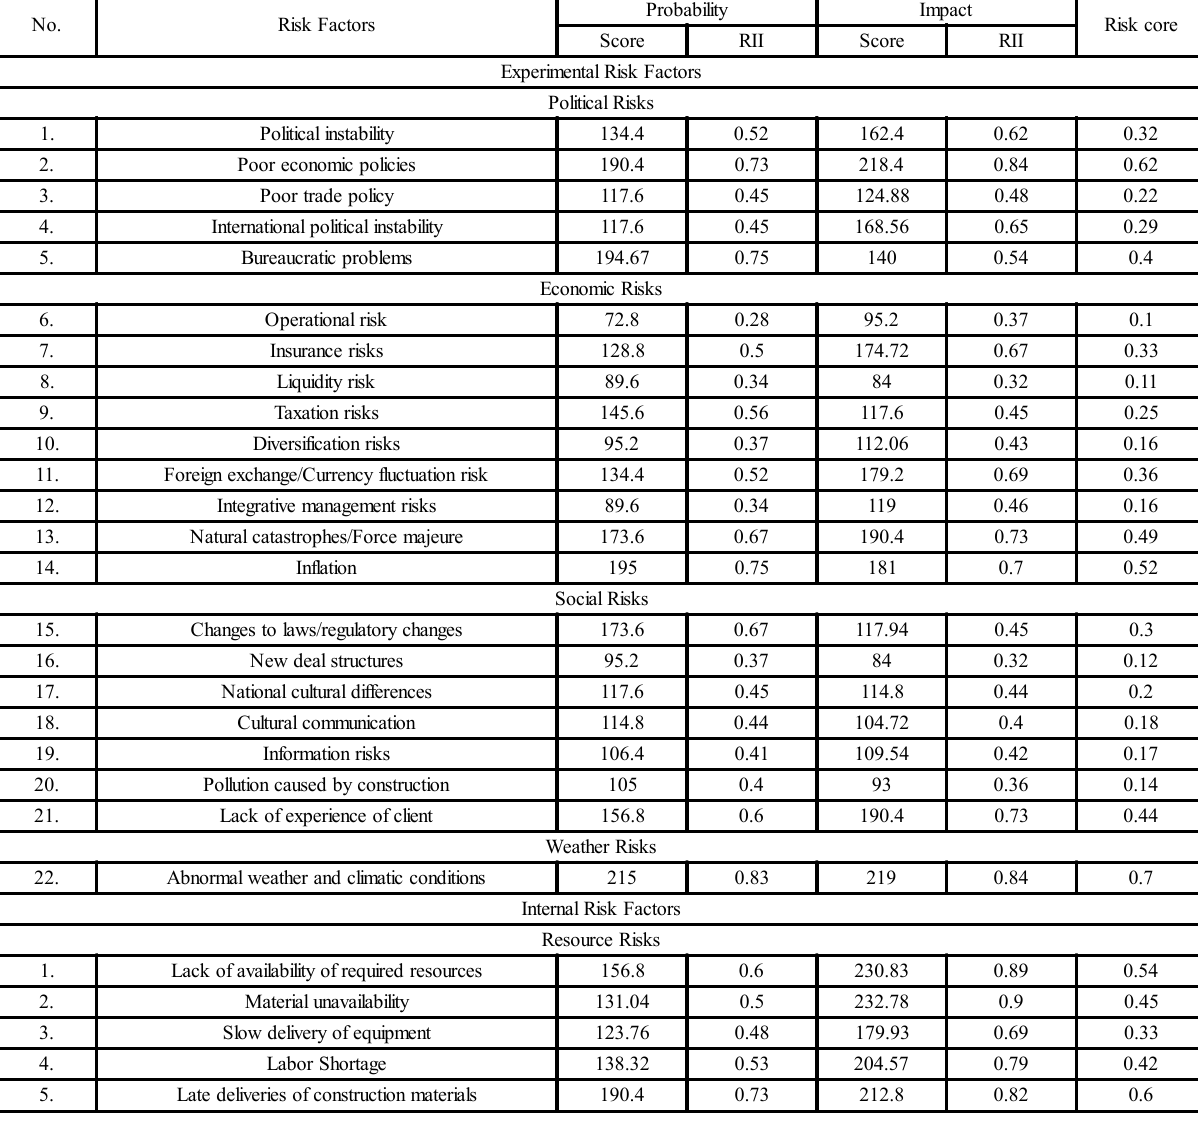
TABLE 1. RISK FACTORS CLASSIFIED WITH THEIR SCORES AFTER